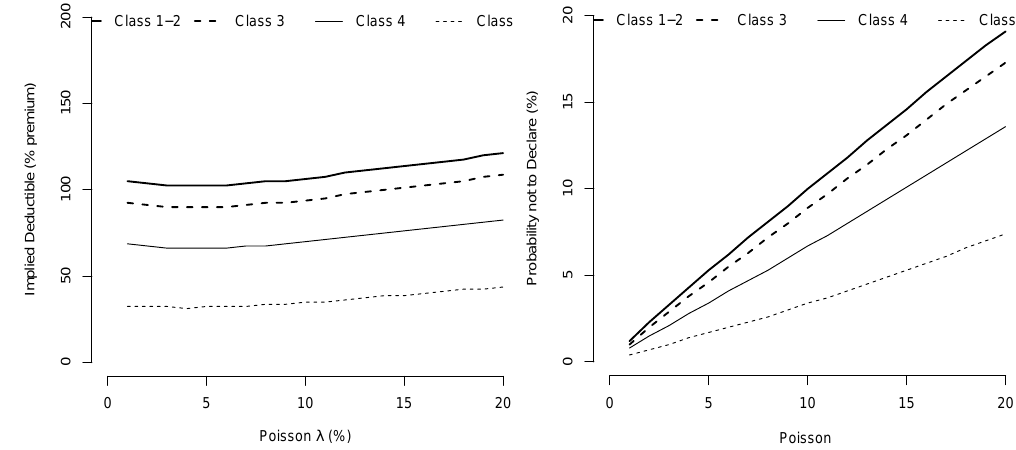
Figure 3. Value of the Deductibles, d (cid:63) s (expressed as a percentage of the premium P s ) and probability not to declare an accident, 1 − π (cid:63) s = P [ L < d (cid:63) s ] as a function of annual accidents frequency λ (in %). Whenever the interest rate r is fixed at 5% and the frequency of accidents is fixed by λ =